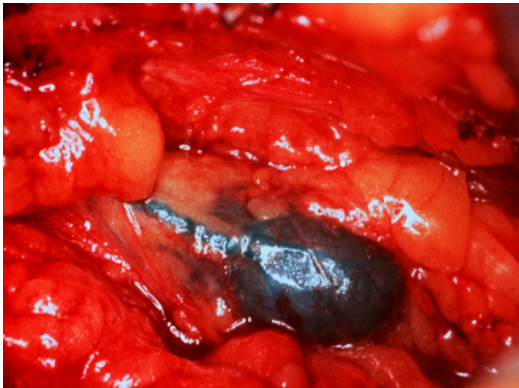
Figure 3. Intraoperative photograph following injection of isosulfan blue shows blue lymphatic channels leading to a blue SLN.